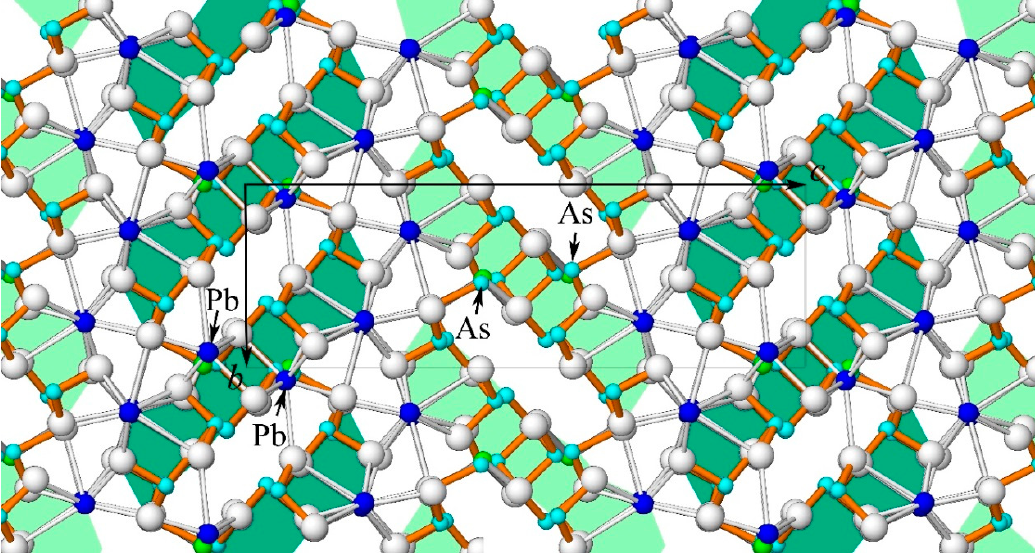
Figure 10. Hypothetical crystal structure of the very Tl ‐ rich phase “SR” based on two chemically (one Pb ‐ rich and one As ‐ rich) and structurally (not related) different ribbons.